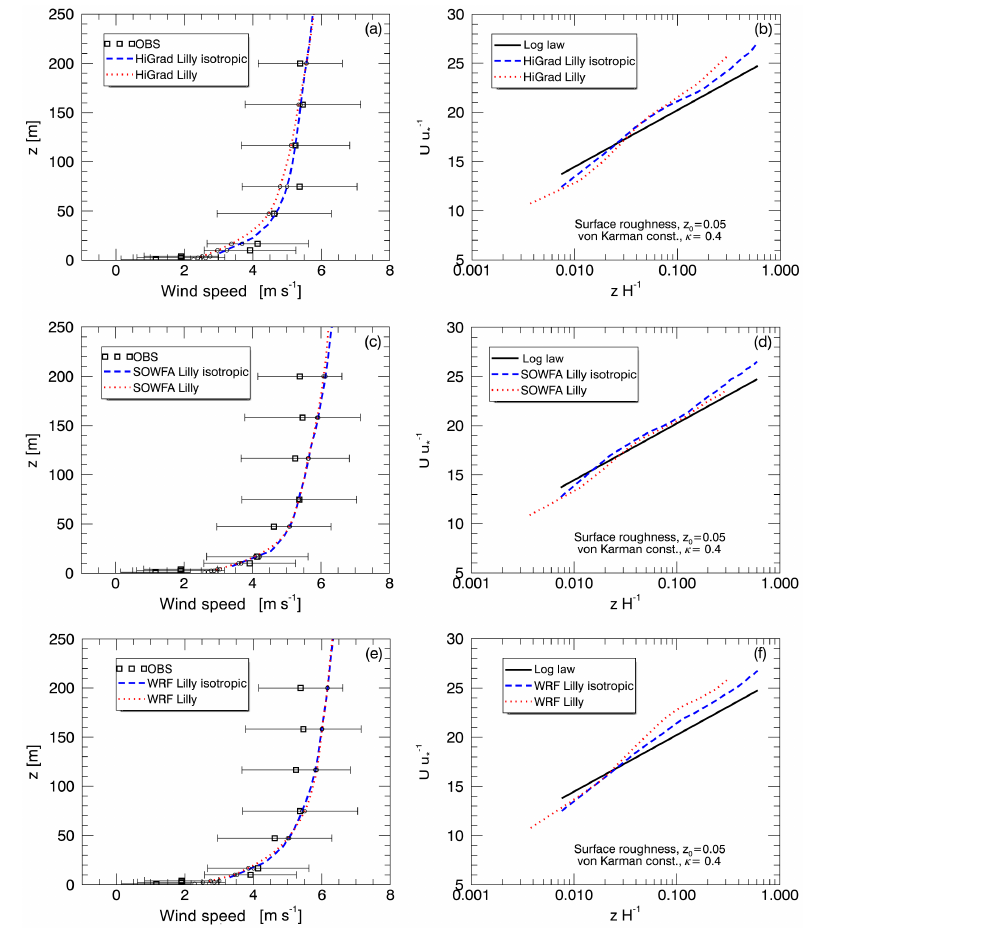
Figure 5. Simulated profiles of time-averaged wind speed plotted against observations (a, c, e) and the theoretical logarithmic profile shape (b, d, f) , from the neutral case study, using HiGrad (a, b) , SOWFA (c, d) , and WRF (e, f)